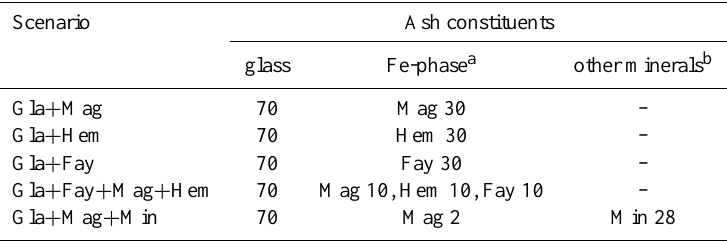
Table 4. Initial composition of the volcanic ash surface in the idealized scenarios considered in this study (values in wt%). Gla + Mag is used in the reference scenario. Other compositions are used in the sensitivity